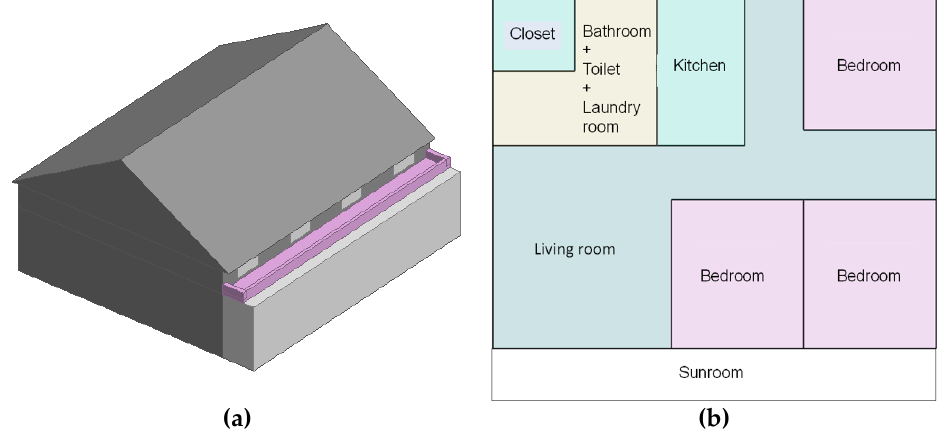
Figure 13. Model of the passive design rural house: ( a ) 3-D model; and ( b ) configuration.